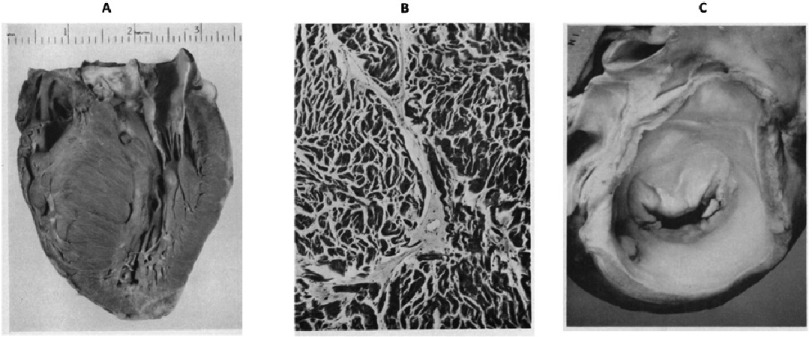
Pathologic images specimen from a report by Dr. Robert Donald Teare published in Britsh Heart Journal in 1958.These demonstrate: (a) localized hypertrophy of the interventricular septum, (b) disordered muscle fibers with variations in size of the fibers, (c) abnormal anterior mitral valve leaflet.39